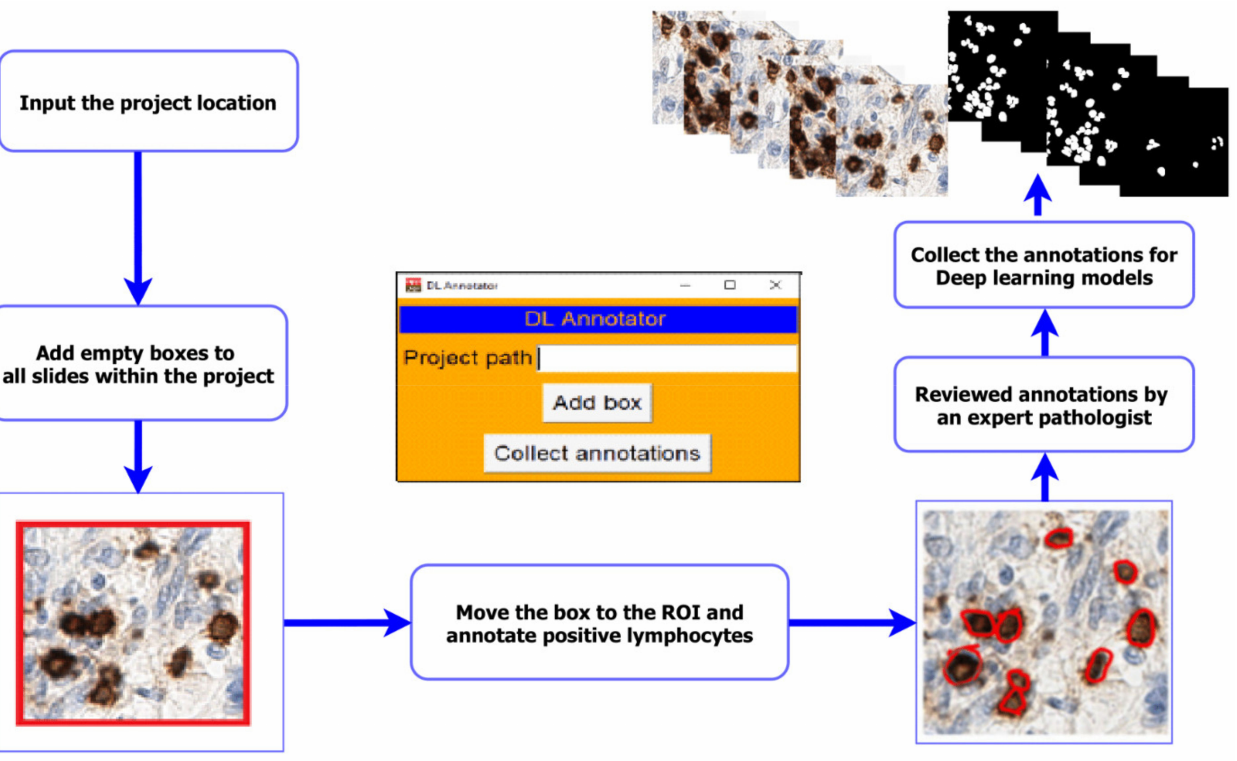
Figure 2. The pipeline of the annotation process. Creating projects for annotator and collection after completed annotations and review by the expert pathologist using the deep learning (DL) annotation